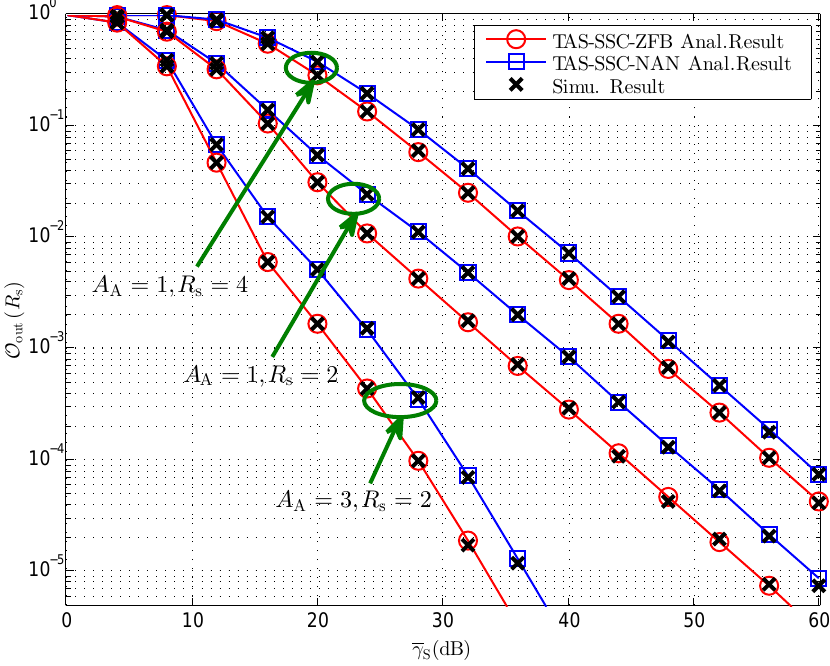
Figure 2. Secrecy outage probability versus different γ S for A J = 3, N B = 2, γ T = 10 dB, M BE = 5, and φ = 0.5.